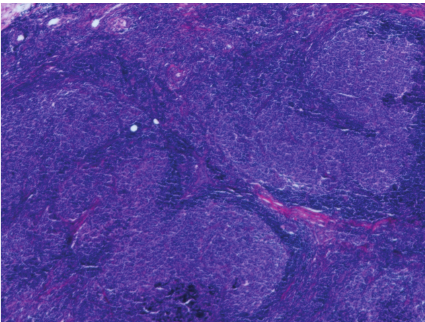
Figure 3: Anterior light field markings for right breast tangents with separate supraclavicular field.